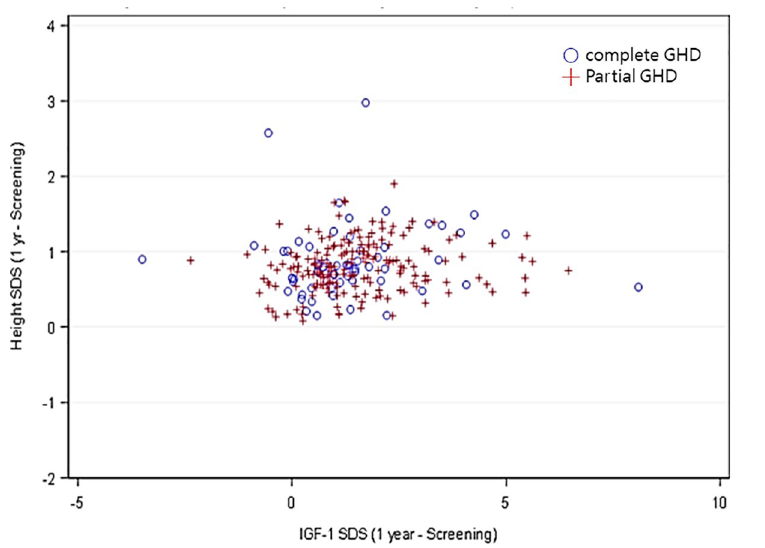
Fig 2. The first-year growth response and change of IGF-I SDS in the IGHD.